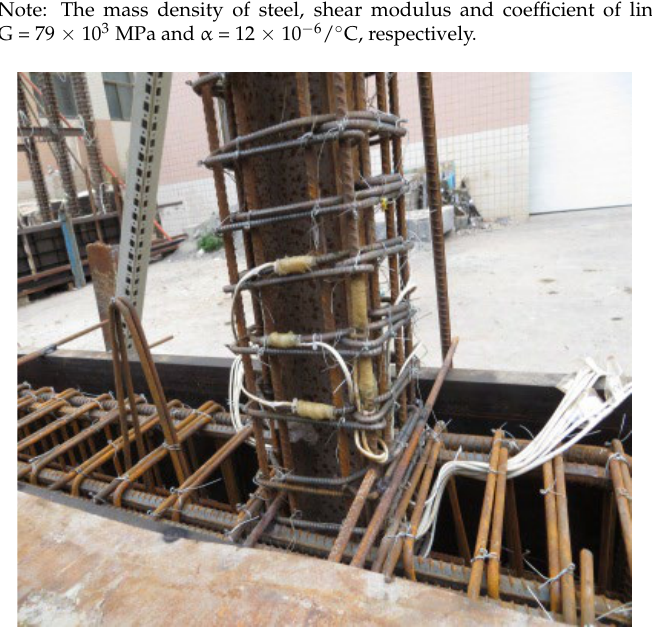
Figure 2. The construction details of an SRUHSC frame. Table 1. Design parameters of the specimens. Specimens Steel Shape